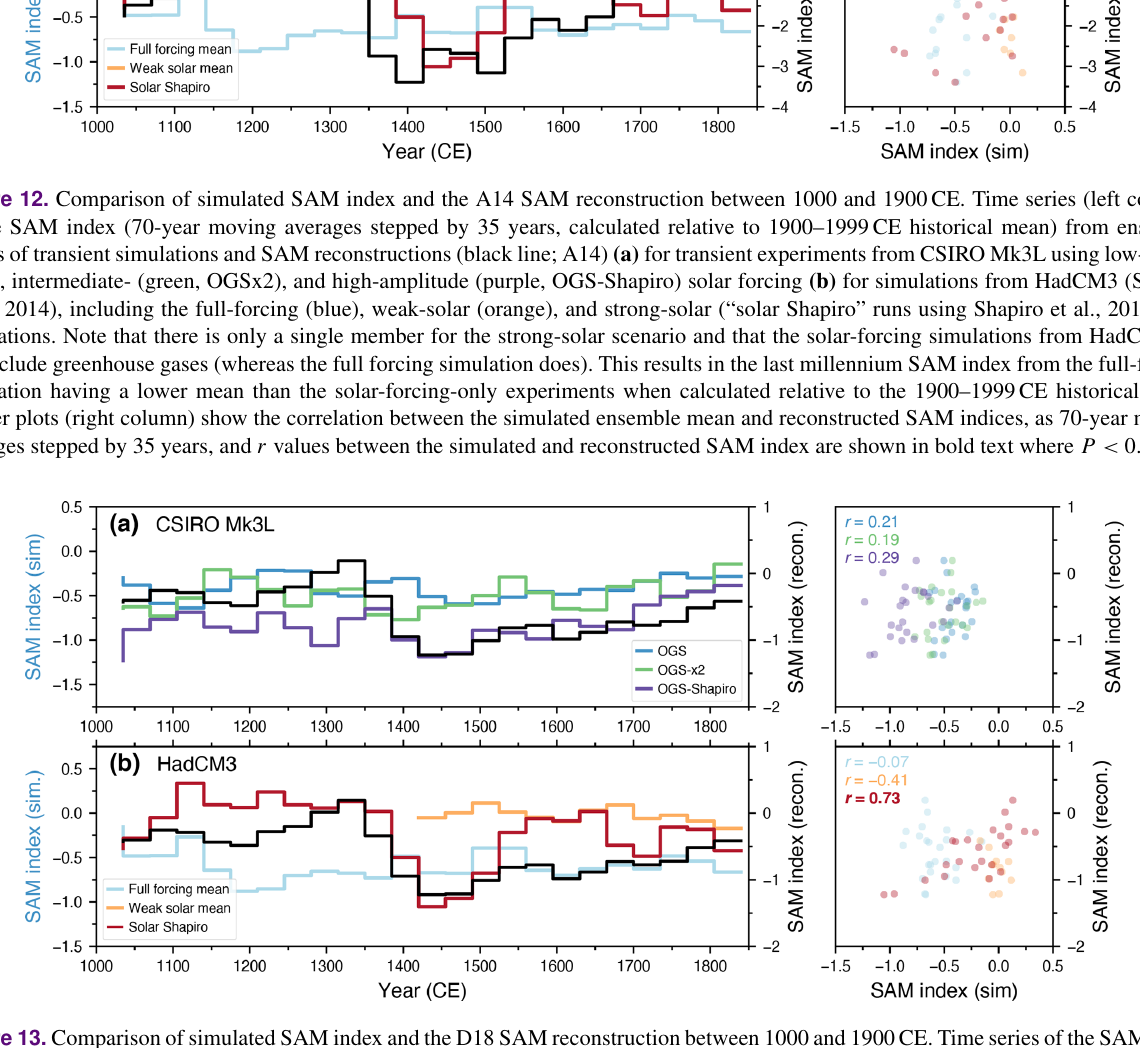
Figure 13. Comparison of simulated SAM index and the D18 SAM reconstruction between 1000 and 1900CE. Time series of the SAM index (70-year moving averages stepped by 35 years; ensemble mean: thick line; ensemble members: thin lines) from transient simulations and SAM reconstruction (70-year moving averages stepped by 35 years) from D18 (black line) for (a) solar transient experiments from CSIRO Mk3L, and (b) simulations from HadCM3 (Schurer et al., 2014), including the full-forcing (blue), weak-solar (orange), and strong-solar (i.e. Shapiro et al., 2011; red) simulations. Note that the solar-forcing simulations from HadCM3 do not include greenhouse gases. Scatter plots show the correlation between 70-year moving averages of the simulated SAM index and the 70-year moving average of the reconstructed SAM index for the ensemble mean, and r values between the simulated and reconstructed SAM index where P < 0 . 05 are shown in bold